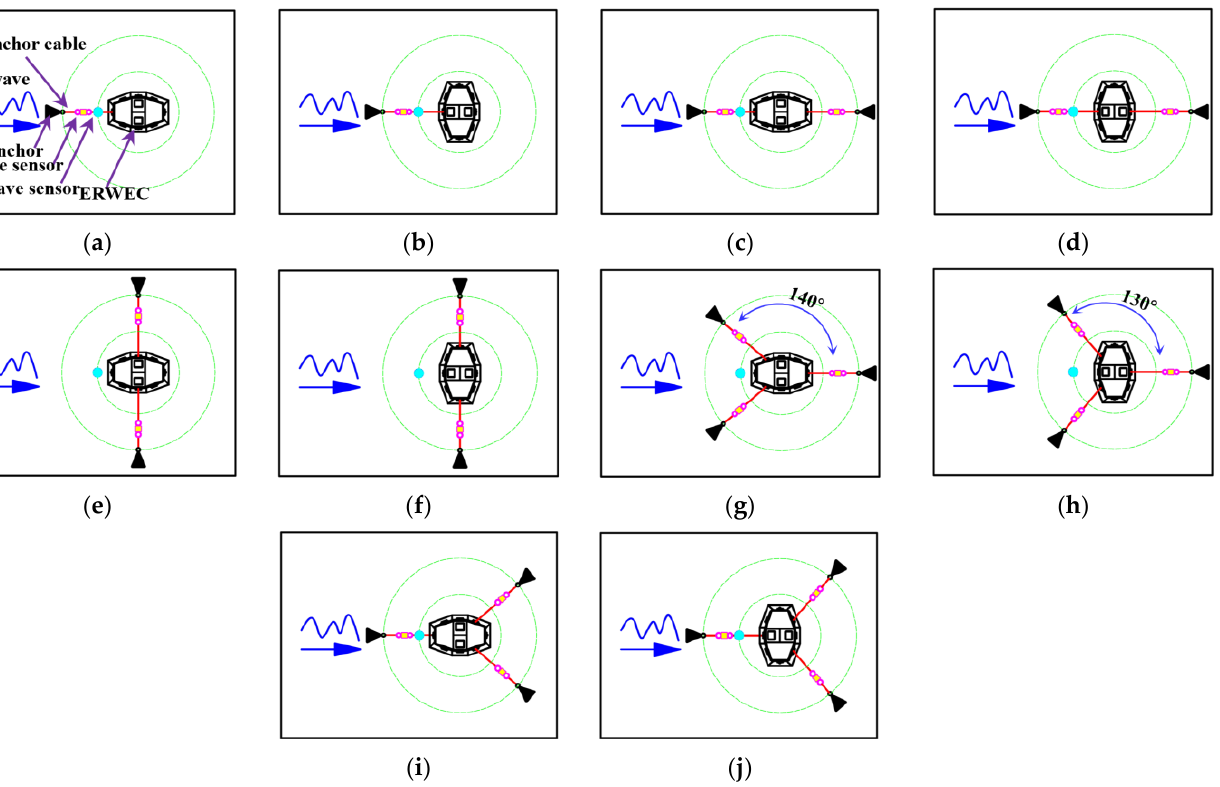
Figure 3. Mooring modes. ( a ) Mooring Mode A. ( b ) Mooring Mode B. ( c ) Mooring Mode C. ( d ) Mooring Mode D. ( e ) Mooring Mode E. ( f ) Mooring Mode F. ( g ) Mooring Mode G. ( h ) Mooring Mode H. ( i ) Mooring Mode I. ( j ) Mooring Mode J.